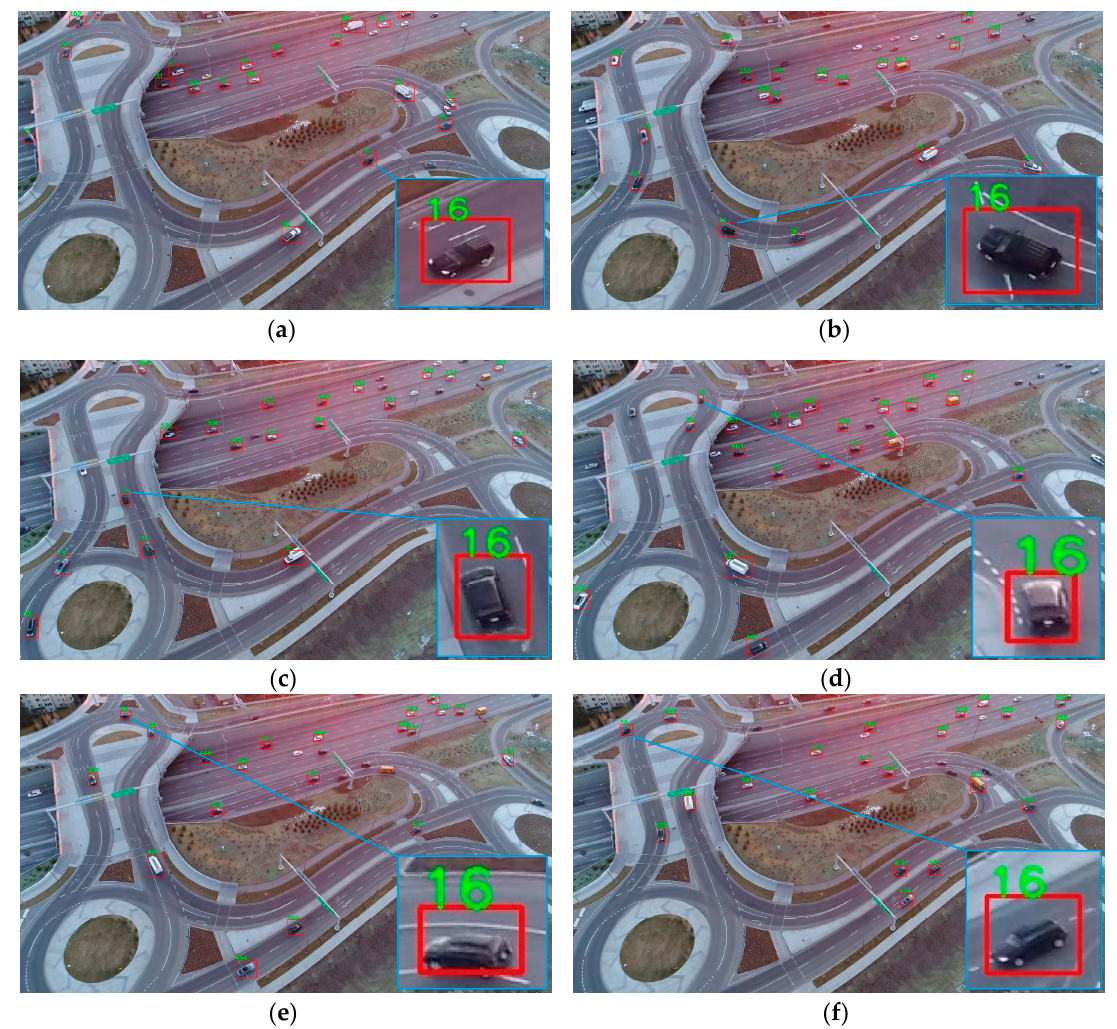
Figure 1. Vehicle detection and tracking at roundabouts from unmanned aerial vehicle (UAV) videos. As vehicle #16 is driving through roundabouts (shown sequentially from ( a ) to ( f )), its appearance and resolution change considerably.